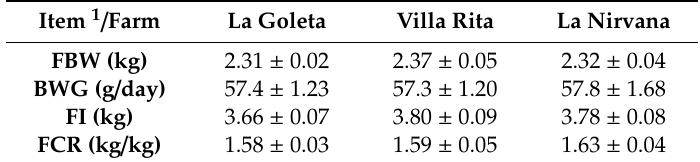
Table 2. Productivity parameters of “Parrilleros” chickens in the three farms under study ( n = 75 per